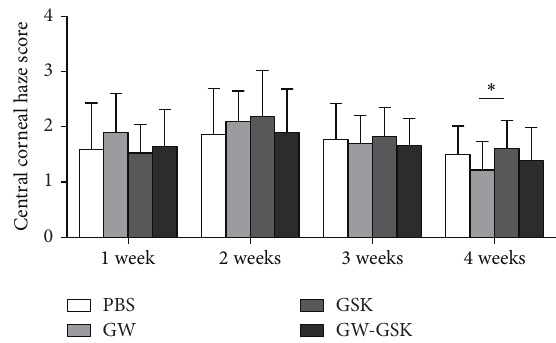
Figure 3: Central corneal haze scores are depicted in the bar graph. Four weeks after surgery, the haze score was lower in the GW501516 group than the GSK3787 group ( 𝑃 < 0.05 ); however, the GW501516 group did not significantly differ from the PBS group ( 𝑃 = 0.108 ). Data are presented as the mean ± SD ( 𝑛 = 18 ), and differences were analyzed with a nonparametric test. ∗ 𝑃 < 0.05 versus GW501516